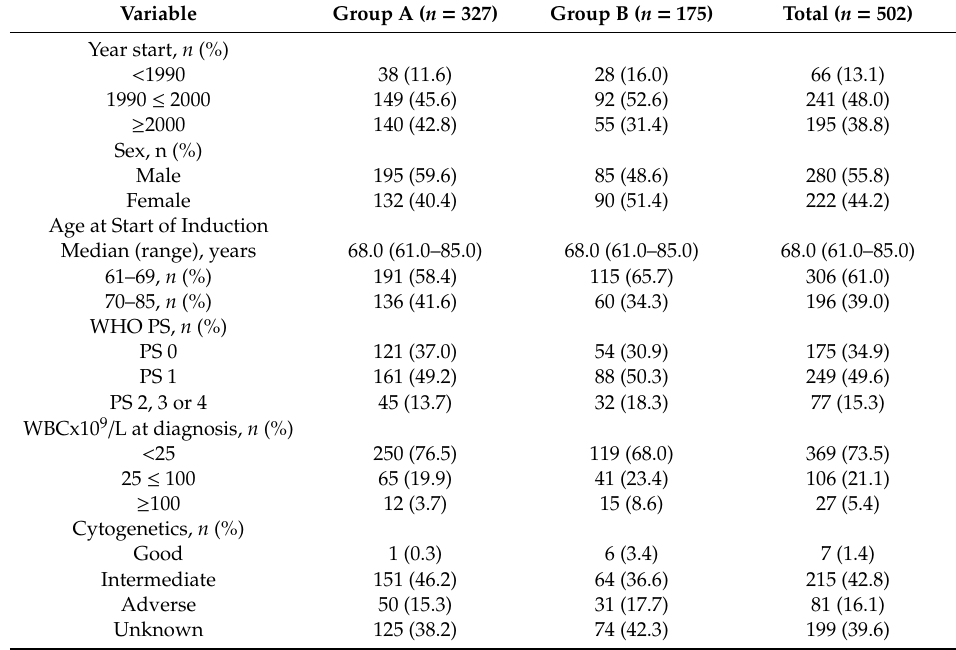
Table 3. Baseline characteristics, treatment period and outcomes in patients with s-AML following MDS (group A) or other malignancies (group B), and for those older than 60 years at the start of